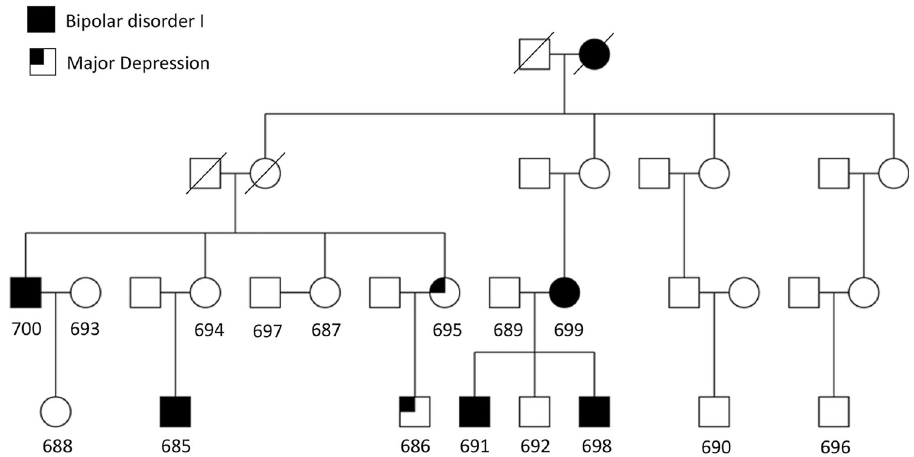
Fig 1. Extended family P101. Partial family P101 pedigree that displays the 16 individuals that were included in this study. These included five affected males (bipolar disorder I: 700, 685, 691, 698, major depression: 686) and two affected females (bipolar disorder I: 699, major depression: 695). In addition, three married-in unaffected controls were included (693, 697, 689) as well as six unaffected family members (688, 694, 687, 692, 690,